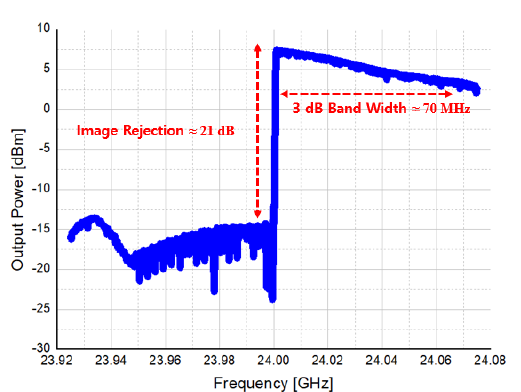
Figure 32. Measurement result of transmitter frequency response.